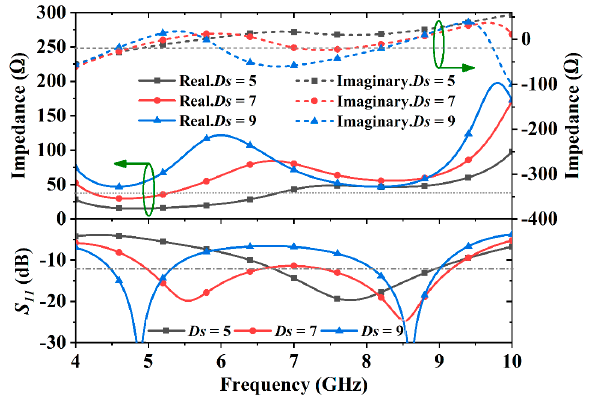
Figure 6. The impedance and S 11 for different values of Ds.